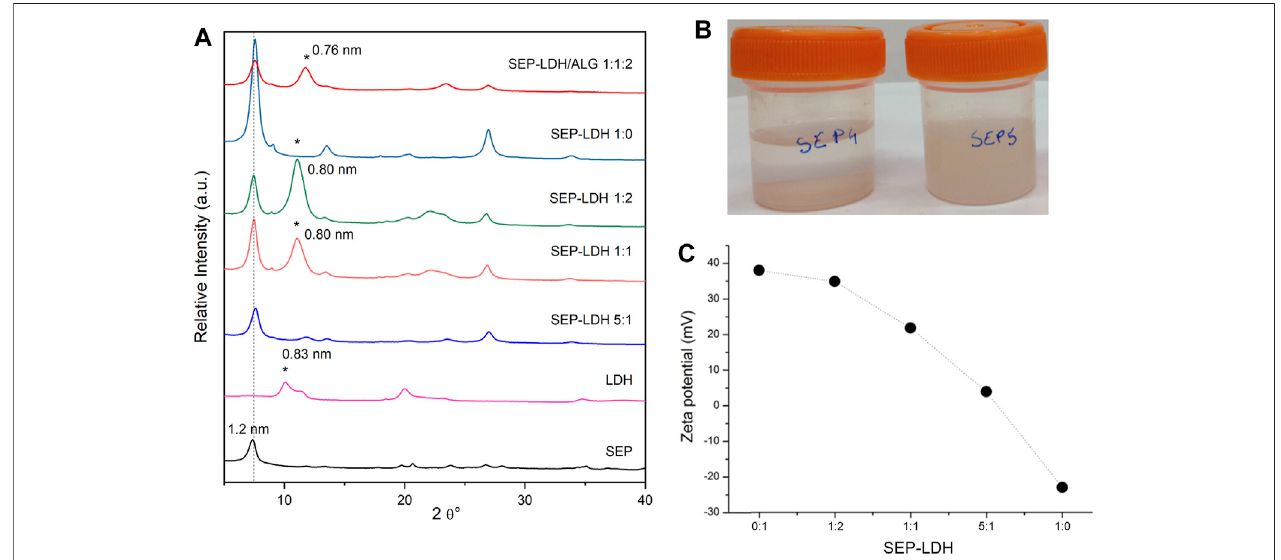
FIGURE 9 | (A) Powder XRD patterns of starting components and sepiolite-LDH and sepiolite/LDH/alginate fi lms of various compositions (*peak of LDH). (B) Aspect after 3 months of its preparation of sepiolite/LDH starting dispersions without (left) and with (right) ultrasonication (20 mg sepiolite/20 mg MgAl-NO 3 in 10 ml of water, US 1 kJ), and (C) evolution of the Z potential for the sepiolite/LDH sonicated